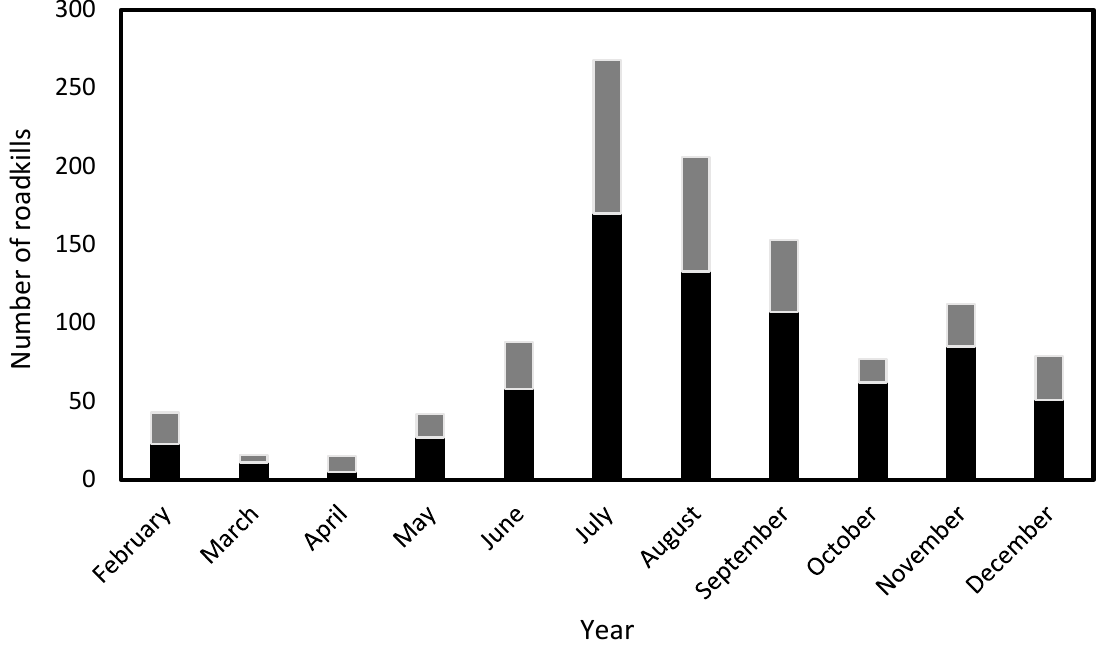
Figure 2. The monthly number of barn owl roadkills that were not ringed (black) and ringed recoveries (gray) from 2009 to 2017 (n = 1073).